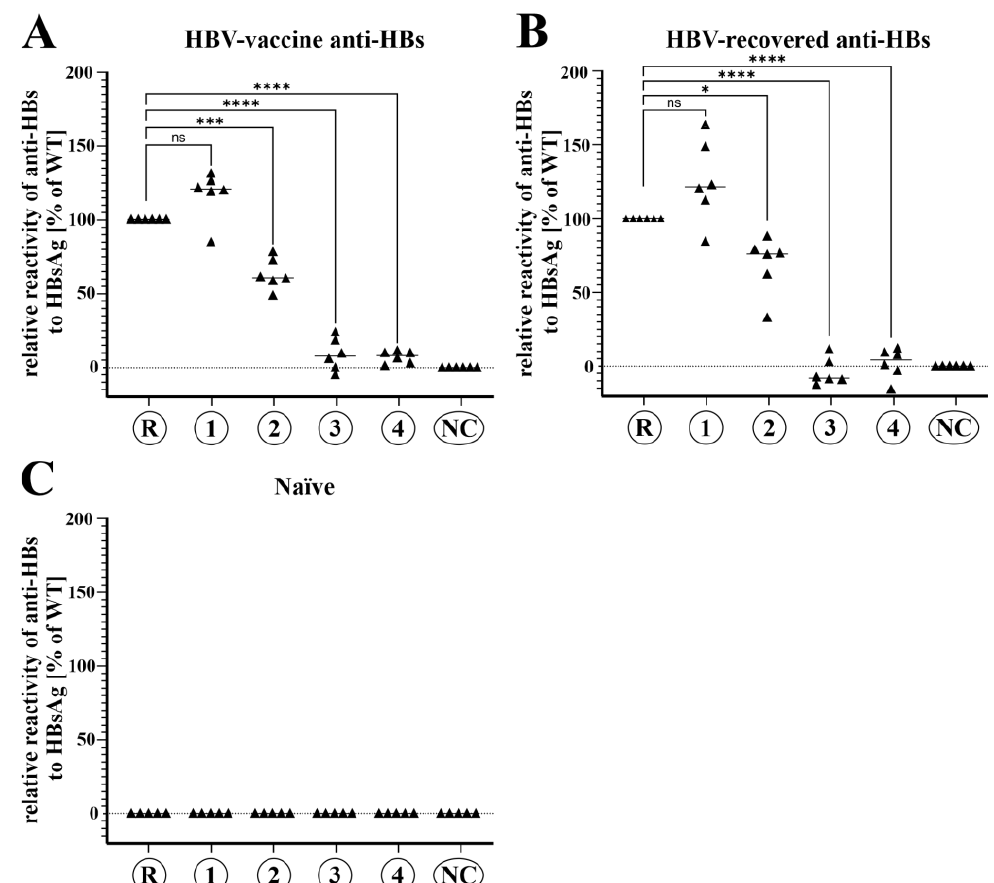
Figure 4. Hyperglycosylation of variant HBsAg masks epitopes recognized by anti-HBs which was induced in six human donors each by vaccination or HBV infection. SHBs within cell culture supernatants was diluted to equal amounts (corresponding to 10 IU/mL WT HBsAg) and preincubated with human anti-HBs-positive sera, containing 50 IU/L anti-HBs. After incubation, quantitative unbound anti-HBs levels were measured with the ARCHITECT anti-HBs-test (Ab- bott ARCHITECT). Data are shown as relative reactivity of vaccinee ( A ), convalescent ( B ), and naïve ( C ) human sera with variant HBsAg. Original data used for calculation of relative reactivities are presented in Table S1. R = SHBs of subgenotype D3 reference strain; 1/2/3/4 = SHBs containing aa1-99 of the reference strain and aa100-226 of the patient-derived sequences of cluster 1/2/3/4, respectively (also refer to Figure 2A). NC = negative control (supernatant of empty pcDNA3.1(+)-transfected cells). ns = not significant, * = p < 0.05, *** = p < 0.001, **** = p < 0.0001 (unpaired t -test). Results obtained for vaccine-induced anti-HBs binding or nonreactivity to variant HBsAg did not differ from anti-HBs originating from natural infection (Figure 4A,B). A noticeable, but not significant, elevated binding of anti-HBs antibodies to cluster 1 compared to the reference was observed (vaccine-induced: 117%/HBV-recovered: 125% relative reactivity (median values)). Recognition of cluster 2 was significantly reduced (vaccine-induced: 63%/HBV-recovered: 69%), while cluster 3 caused substantial reactivity loss for vaccine antibodies and total loss of reactivity with convalescent antibodies (vaccine- induced: 9%/HBV-recovered: − 3%). Only residual reactivity was observed for both vaccine-induced antibodies and those derived after natural infection incubated with SHBs of cluster 4 (vaccine-induced: 7%/HBV-recovered: 2%). No HBs-specific antibodies could be detected with the HBV-naïve sera (Figure